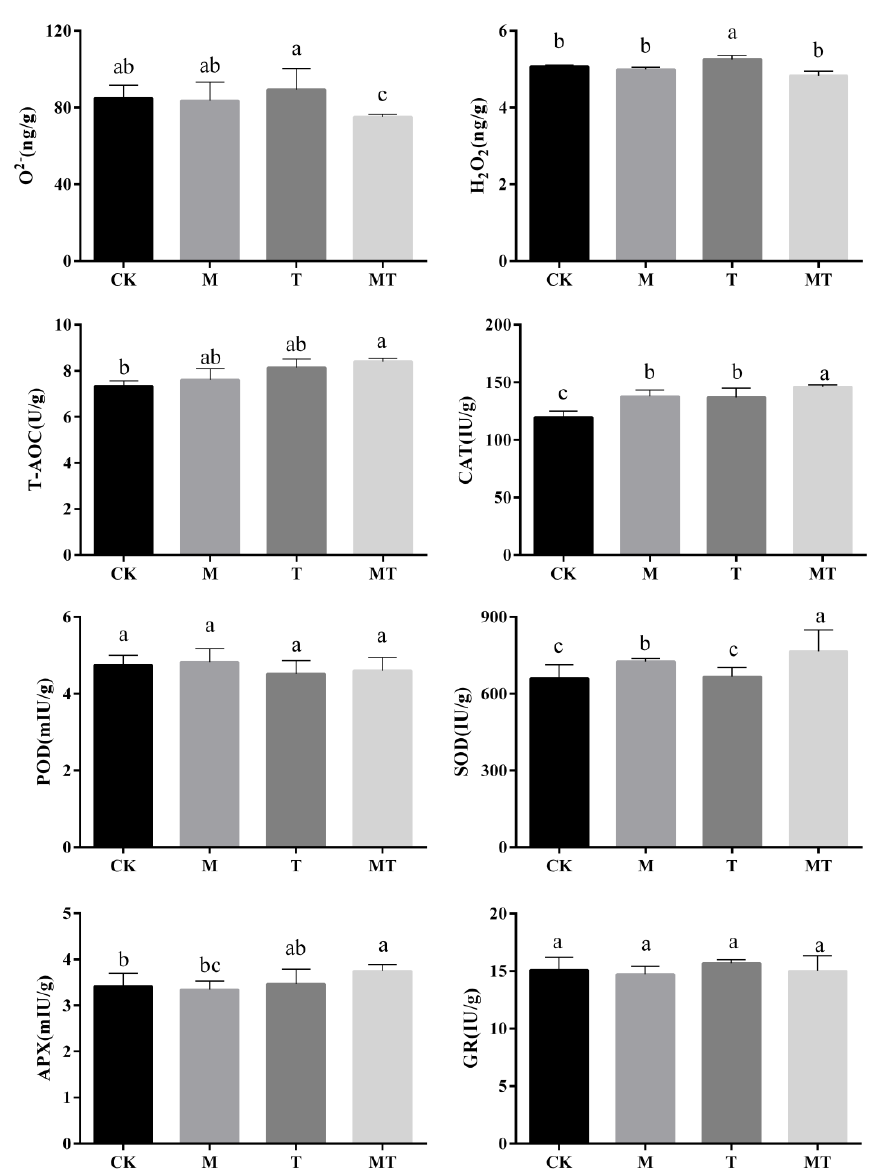
Figure 4. Influences of melatonin and cold stress on the O 2 − and H 2 O 2 contents, total antioxidant capacity (T-AOC) and antioxidant enzyme activities in banana leaves. Different letters above bars indicate significant differences among samples determined using Duncan’s test at the p < 0.05 level. All values are displayed as mean ± standard deviation for three replications at the p < 0.05 level. CK: control; M: melatonin treatment; T: low-temperature treatment; MT: combined melatonin and low-temperature treatment.